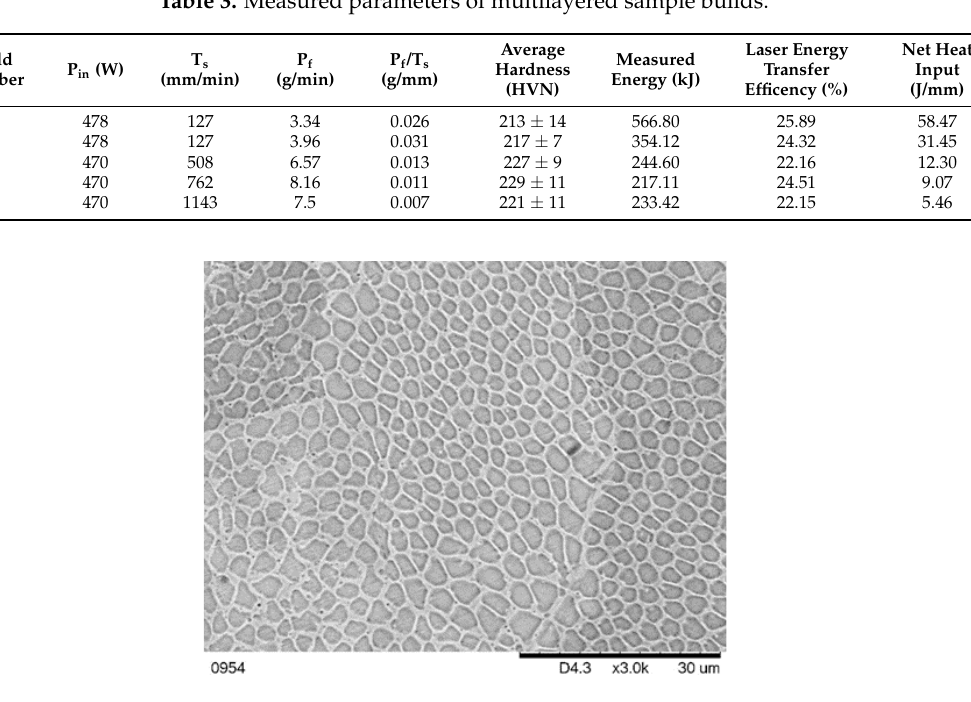
Figure 10. Fine cellular subgrain structure (~2 µm) of multilayered sample from builds #36 & 55, in the as-built condition, which had Vickers values of 227 + 9 and 229 + 11, respectively.